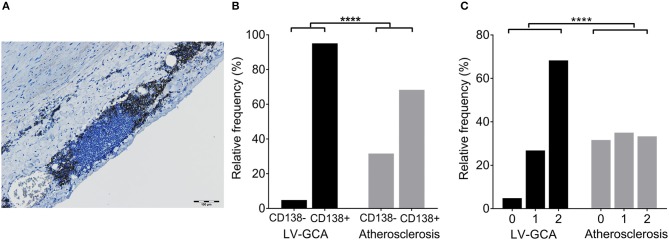
Plasma cells in ATLOs of LV-GCA and atherosclerosis patients. (A) Representative image of an ATLO with CD138+ plasma cells in niches (brown). (B) Histogram showing the frequency of plasma cell niches per ATLO. CD138-: no plasma cells present, CD138+: plasma cells present. (C) Histogram showing the frequency distribution of plasma cell score. Plasma cells were scored semi-quantitatively by 2 independent investigators on a 3-point scale (0–2) with 0 = no positive cells, 1 = few positive cells (< 10), and 2 = moderate to large number of positive cells (>10). Fischer's exact test was used in (B) and the Mann-Whitney U-test was used in (C). ****P < 0.0001.